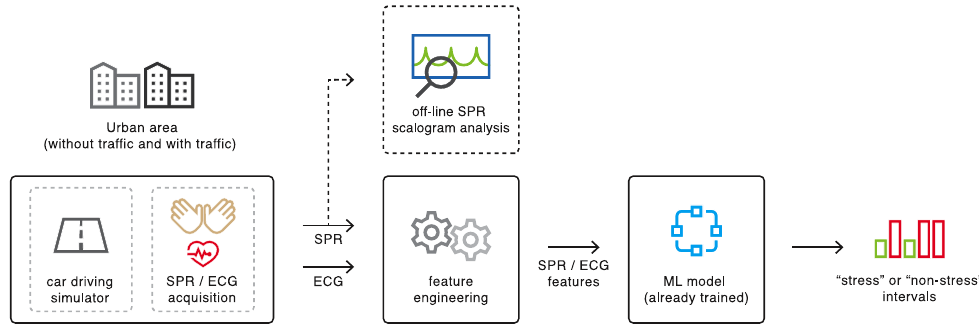
Figure 1. Block scheme of the proposed system.